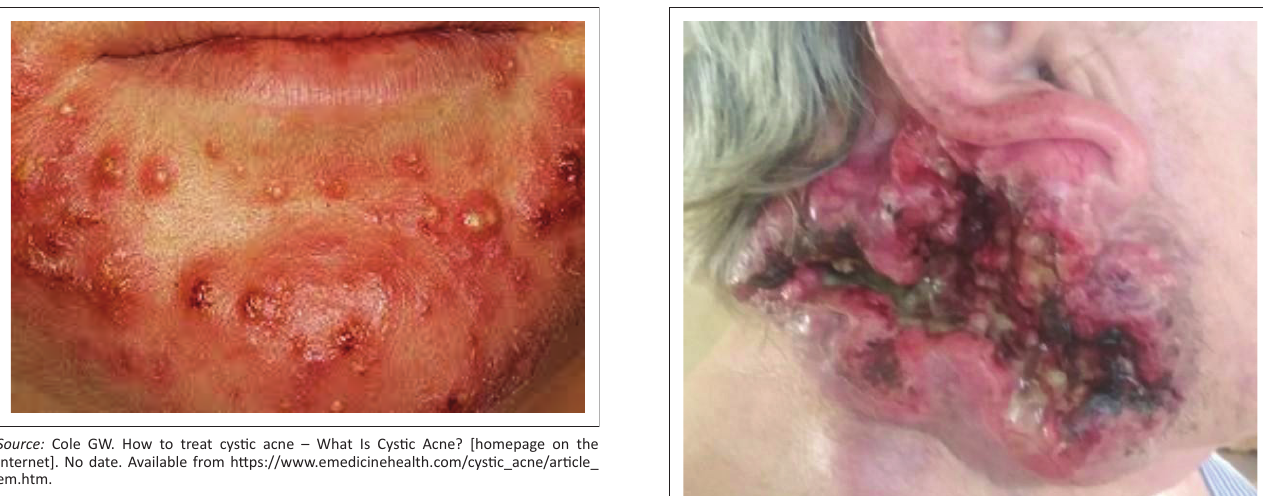
FIGURE 1: Multiple choice question clinical scenario.